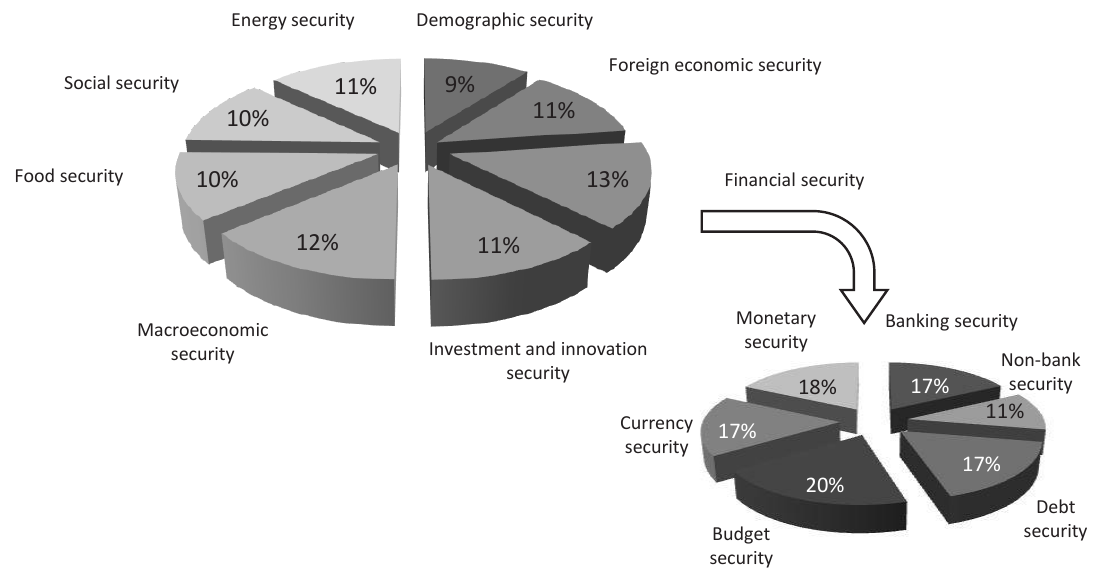
Figure 1. Weighted coefficients of the components of economic and financial